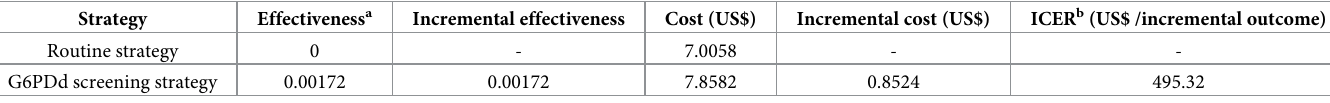
Table 3. Cost-effectiveness results (per person) for the base-case analysis in the Brazilian Amazon in 2020 United States Dollars (US$).